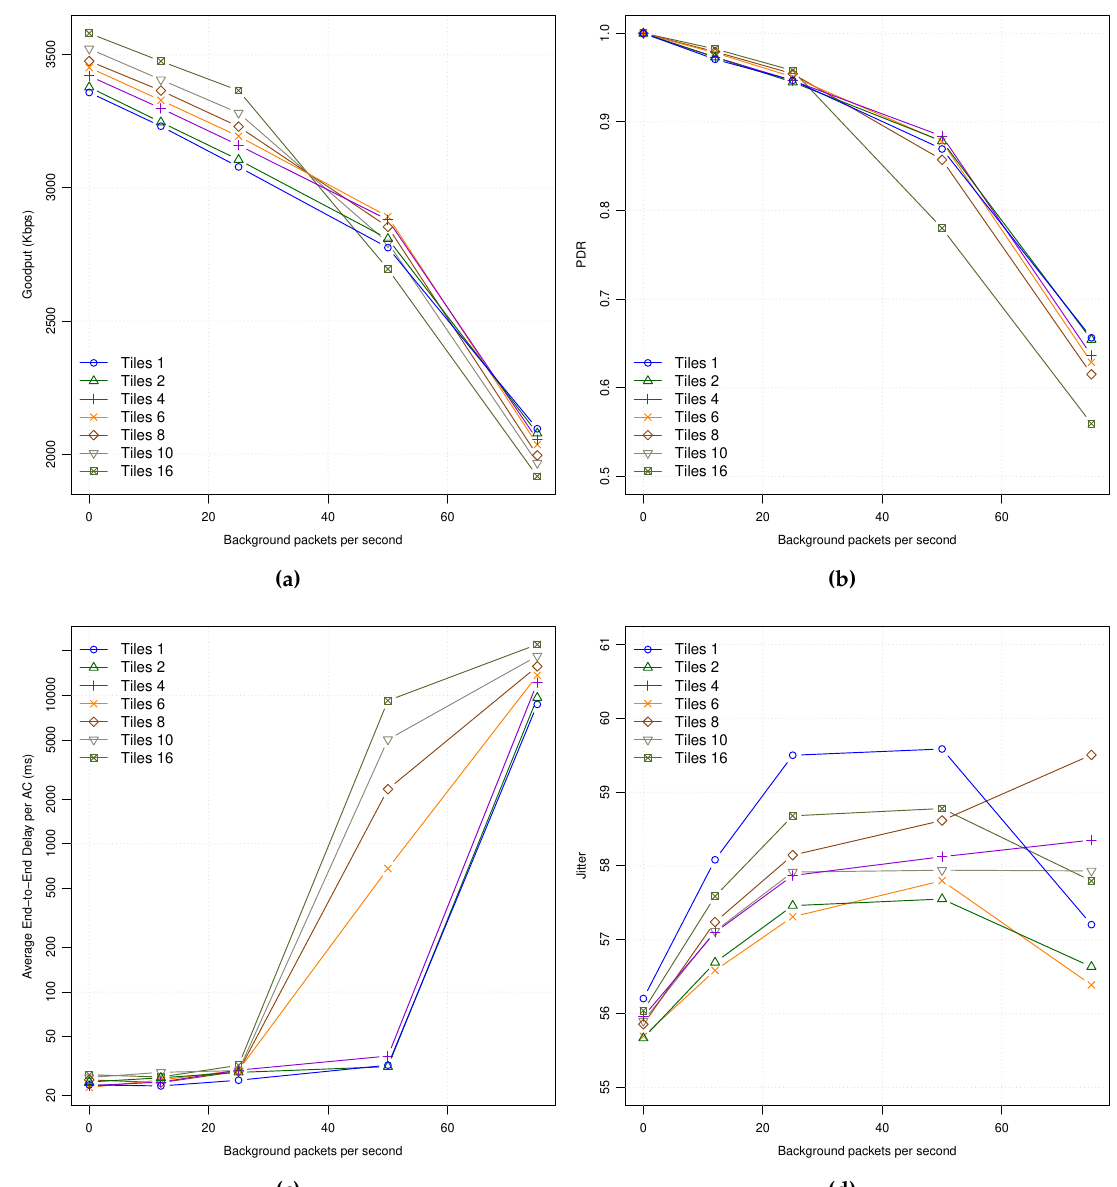
Figure 5. APP statistics for AI coding mode and for all the tiles per frame layouts: ( a ) GP. ( b ) PDR. ( c ) E2E-Delay. ( d )